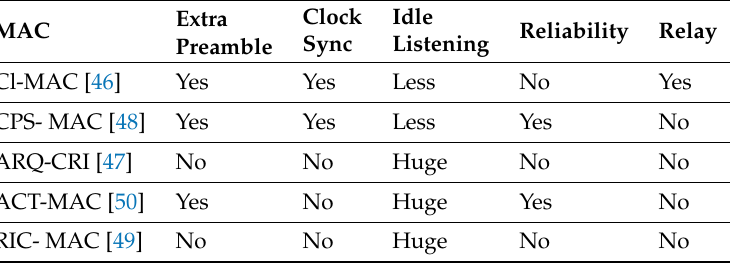
Table 2. Comparative analysis of different asynchronous Cooperative